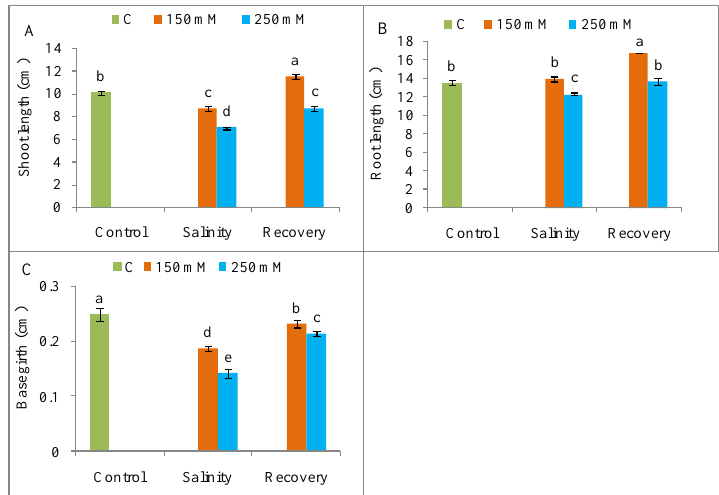
Figure 1. Tomato plant growth ( A ) shoot height, ( B ) root length, and ( C ) base girth under salinity (150 and 250 mM NaCl) and after a 48 h recovery period. Data means (±SD) were calculated from three replications. Statistically significant values are indicated by dissimilar letters (Fisher’s least significant difference (LSD) test, P ≤ 0.05).